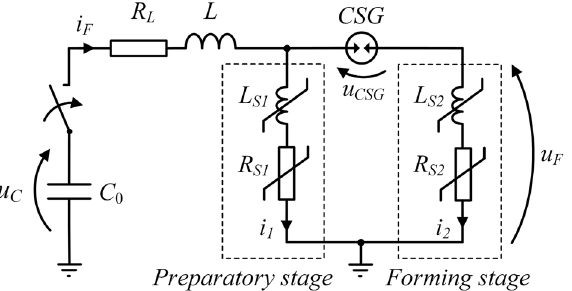
Figure 6. S implified TSFF-based PFS lumped circuit model (refer to the descriptive text for explanation of